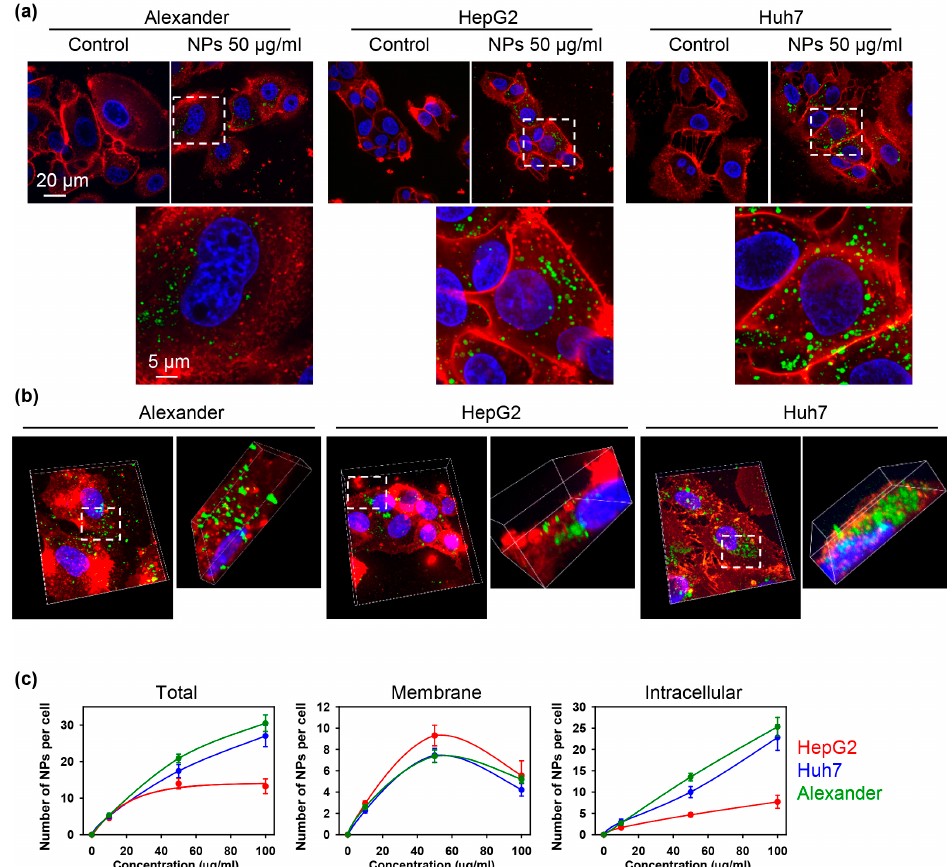
Figure 3. Quantification of the nanoparticle uptake in three distinct hepatic cell lines. ( a ) Representative high-resolution confocal images of cells incubated with nanoparticles. Huh7, HepG2 and Alexander cells were treated for 12 h with NPs 50 µ g Fe mL − 1 (green). Cell membranes were labeled with CellMask ™ Orange (red). ( b ) 3D reconstruction of NP-labelled cells. Cells were treated like in ( a ) and 3D rendering was done using ImageJ software. ( c ) Quantification of nanoparticle uptake. Cells were treated with di ff erent nanoparticle concentrations for 12 h. After the treatment cells were labeled with CellMask ™ Orange and imaged using IXplore SpinSR Olympus microscopy system. Number of particles per cell was calculated using image processing by Particle_in_Cell_3D macro in ImageJ. Data are expressed as mean ± SEM of at least three independent experiments ( n = 30 cells).